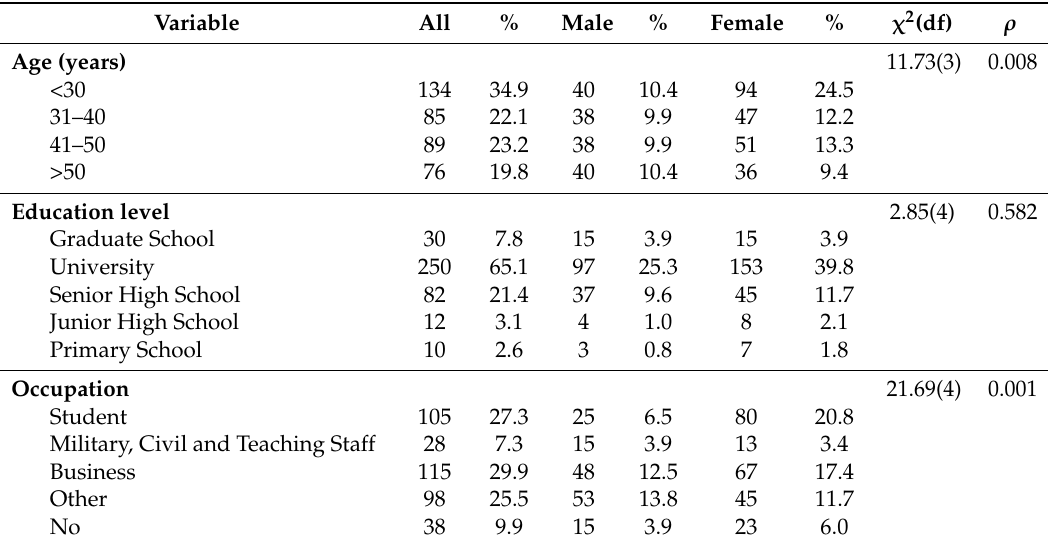
Table 2. Health service consumer characteristics ( n = 384).